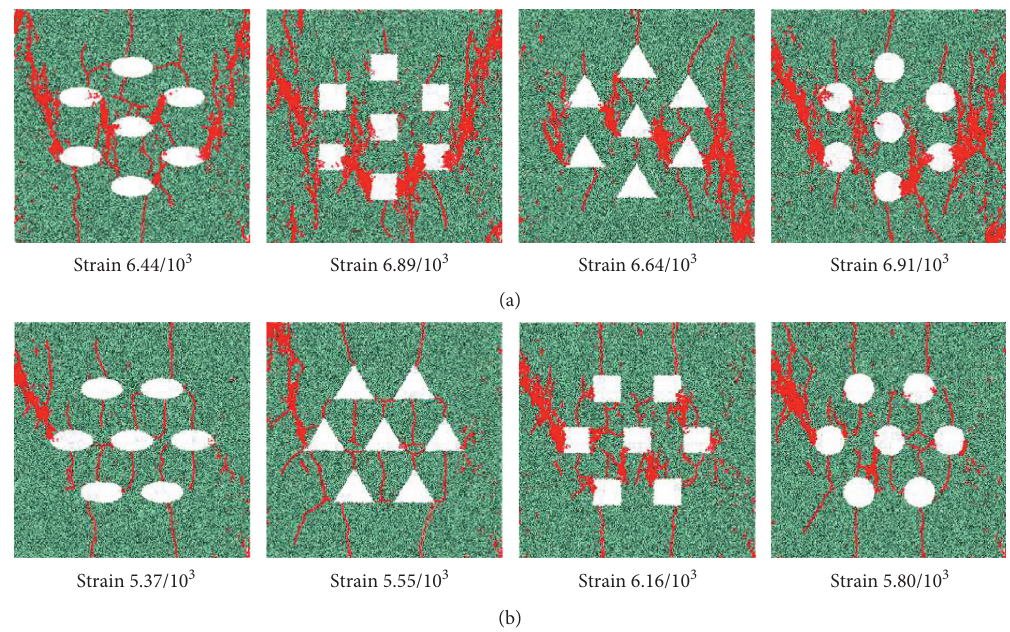
Figure 8: Crack evolution of the (a) vertical orientation model and (b) horizontal orientation model.